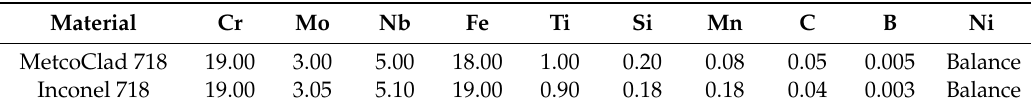
Table 1. Chemical composition (wt %) of the employed materials [17,18].